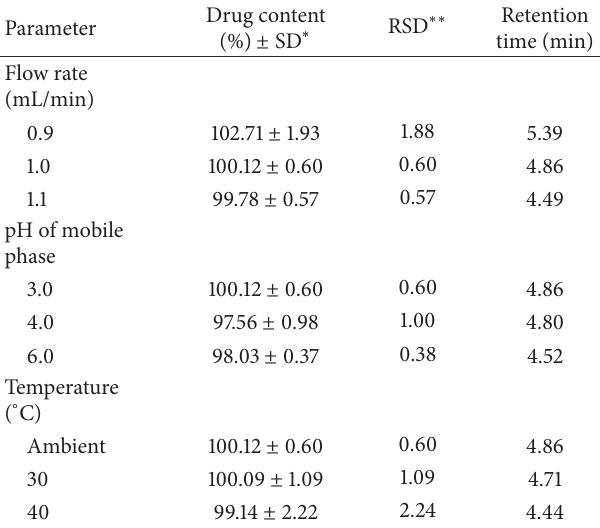
∗ SD = standard deviation; ∗∗ RSD = relative standard